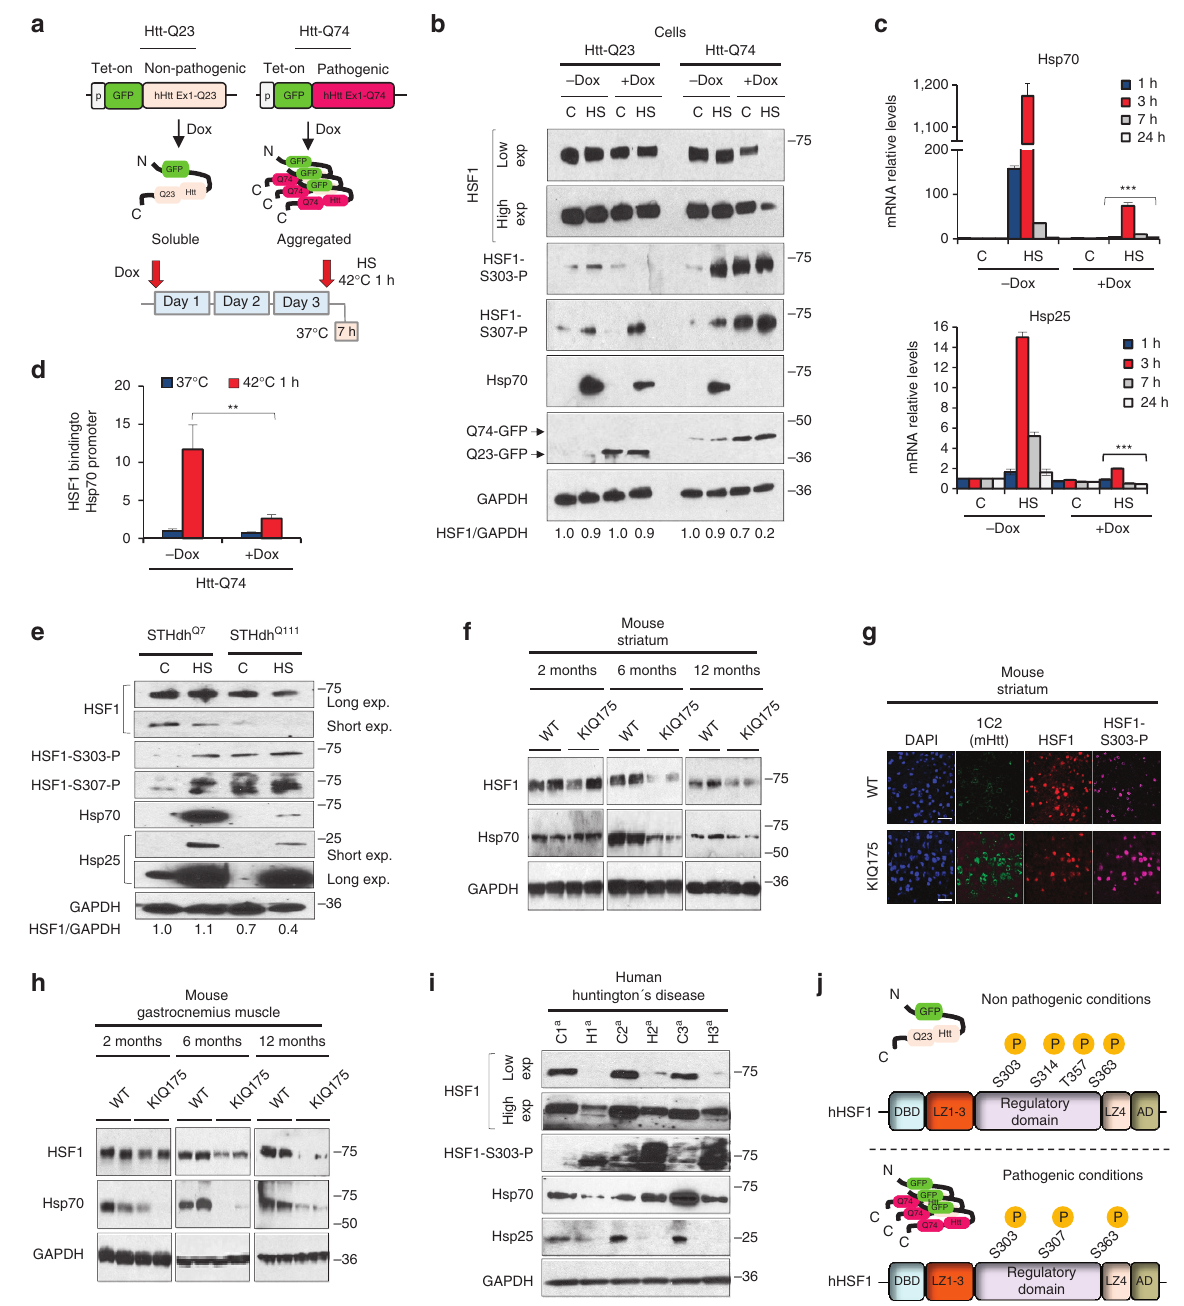
Figure 1 | HSF1 levels are decreased and P-Ser303/307 increased in HD. ( a ) Diagram of the PC12-HttQ23 and Htt-Q74 proteins and experimental design. ( b ) Cells expressing either Htt-Q23 or Htt-Q74 were cultivated at 37 (cid:2) C ( c ) in the presence of tetracycline (Dox) for 3 days to induce expression, exposed to heat shock 1h at 42 (cid:2) C, allowed to recover at 37 (cid:2) C for 7h (HS) and protein extracts immunoblotted with the indicated antibodies. HSF1 bands were quantitated using Quantity One image software (BioRad) and values normalized using GAPDH as loading control and referenced to control at 37 (cid:2) C ( c ) in the absence of (cid:2) Dox. ( c ) qRT-PCR analysis of the Hsp70 and Hsp25 genes in Htt-Q74-expressing cells as in B. HS ( þ Dox) group was compared with HS ( (cid:2) Dox) group. Error bars represent means ± s.e.m., n ¼ 4. Unpaired t -test, *** P o 0.001. ( d ) Analysis of Hsp70 promoter occupancy by HSF1. Error bars represent means ± s.e.m., n ¼ 3. Unpaired t -test, ** P o 0.01. ( e ) Mouse-derived striatal STHdh Q7 and STHdh Q111 cells were cultured at 33 (cid:2) C ( c ), heat shocked at 42 (cid:2) C 1h with recovery at 33 (cid:2) C for 7h and immunoblotted with the indicated antibodies. HSF1 was quantified using Quantity One image software and normalized using GAPDH as loading control and referenced to control at 37 (cid:2) C in the non-pathogenic STHdh Q7 . ( f ) Striatal samples from Wild type (WT) C57BL/6 or KIQ175 mice at 2, 6 and 12 months analysed by immunoblotting ( n ¼ 4). ( g ) Dorsal striatal sections from WT and KIQ175 mice ( n ¼ 3) at 6 months assayed by immunohistochemistry (IHC) for mHtt aggregation (1C2), HSF1 and HSF1-S303 phosphorylation using DAPI staining as control. Scale bar: 10 m m. ( h ) Gastrocnemius muscle extracts from WTand KI175 mice ( n ¼ 4) of the indicated age, immunoblotted for HSF1, Hsp70 and GAPDH. ( i ) Protein extracts from HD patient striatum (Supplementary Table 1) and controls immunoblotted with indicated antibodies. ( j ) HSF1 phosphoproteomic analysis under non-pathogenic ( (cid:2) Dox) and pathogenic ( þ Dox) conditions in hsf1 (cid:2) / (cid:2) MEF inducible cell line expressing GFP-Htt-Q74 expressing HSF1. See Supplementary Fig. 8 for uncropped immunoblots. HSF1 represented by the Regulatory domain, DBD; DNA binding domain; LZ1-3 and LZ4; leucine zipper domains. NATURE COMMUNICATIONS|8:14405|DOI: